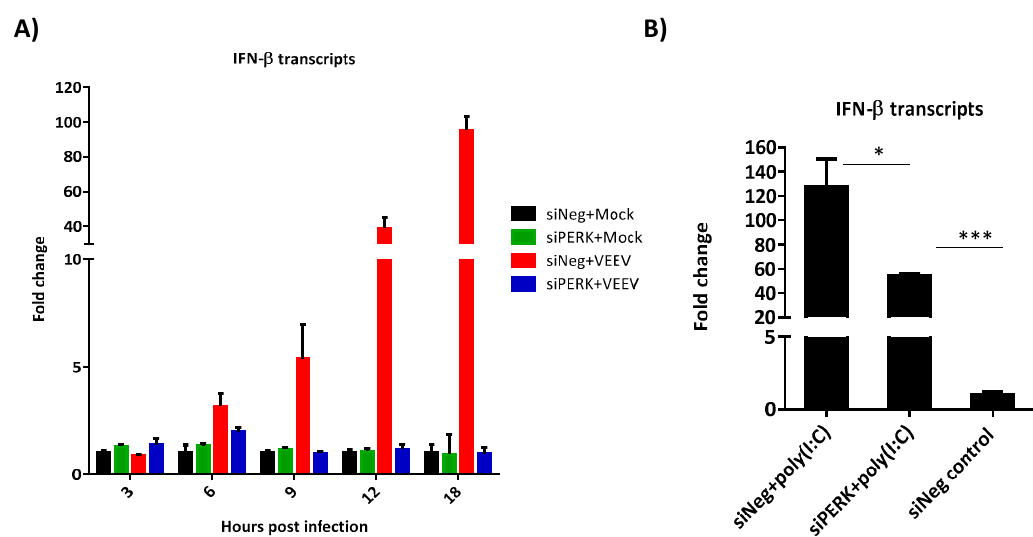
Figure 5. Loss of PERK does not result in elevation of interferon beta (IFN- β ) production. Primary astrocytes were transfected with 100 nM of siNeg or siPERK siRNAs. At 48 h post transfection, ( A ) Cells were infected with VEEV TC-83 (MOI 5). Total RNA was isolated at 3, 6, 9, 12, and 18 hpi. IFN- β gene expression was determined by RT-qPCR. Fold changes were calculated relative to 18S ribosomal RNA and normalized to mock samples using the ∆∆ Ct method. Data are expressed as the mean ± SD ( n = 3). ( B ) Cells were treated with poly(I:C) complexed with Lipofectamine 2000 for 6 h. siNeg transfected cells treated with Lipofectamine only was used as a control. IFN- β gene expression determined as described above. Data are expressed as the mean ± SD ( n = 3). * p ≤ 0.5, *** p ≤ 0.001.